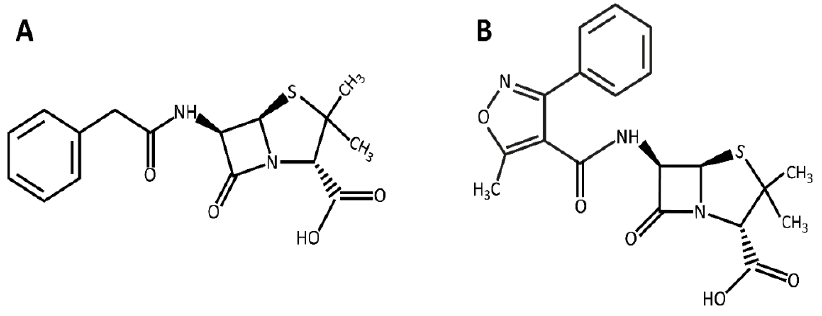
Figure 1. Chemical Structure of ( A ) penicillin and ( B ) oxacillin.